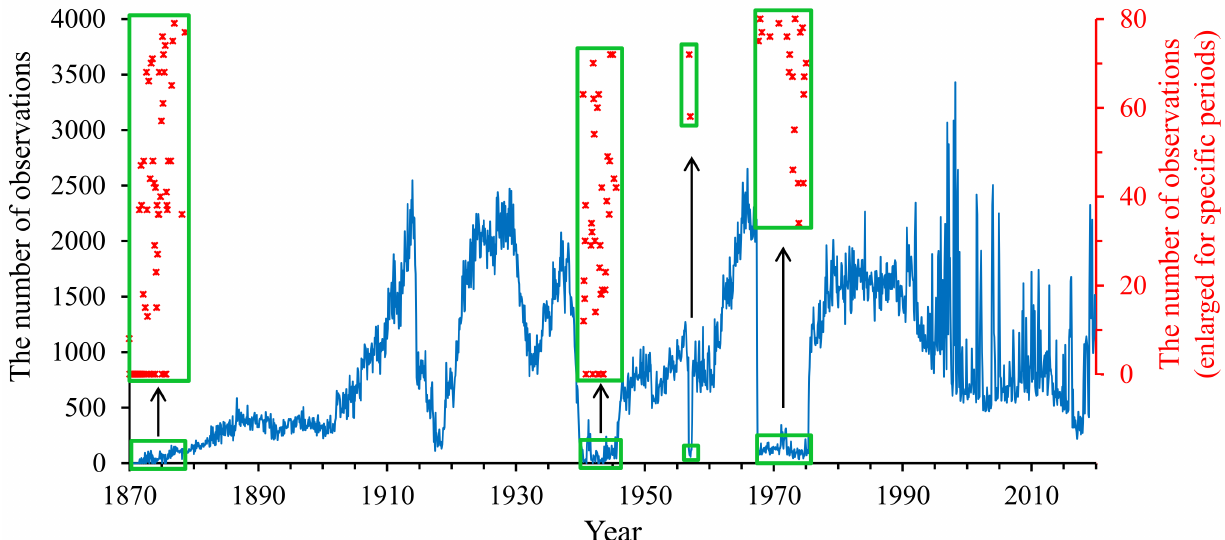
Figure 2. Monthly series of the numbers of raw SST measurements (ICOADS) within Red Sea. The dots are valued by the right coordinate axis, standing for the enlarged figure of partial line